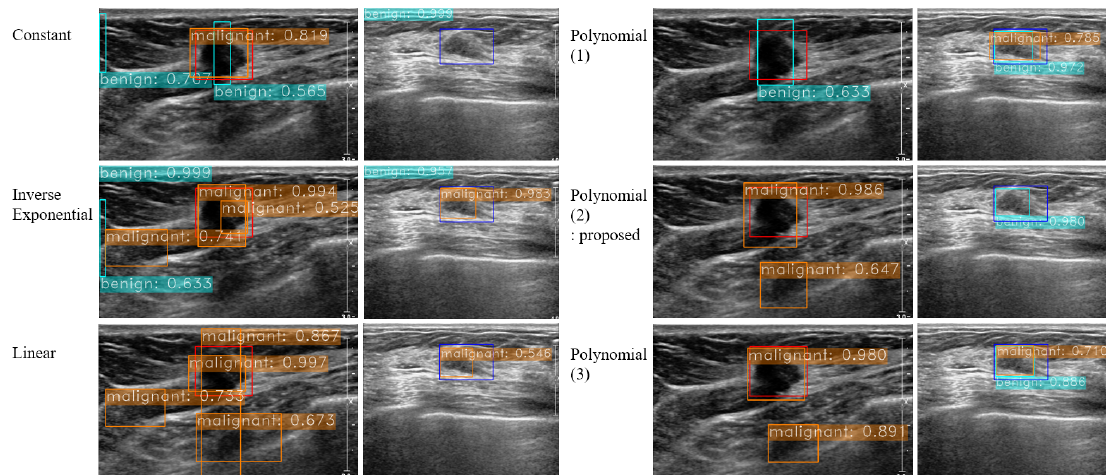
Figure 4. Qualitative results for controlling α . Bounding boxes colored red/blue are ground truth boxes for malignant/benign masses. Bounding boxes colored orange/cyan are predictions for malignant/benign masses. Two cases are presented for each method.